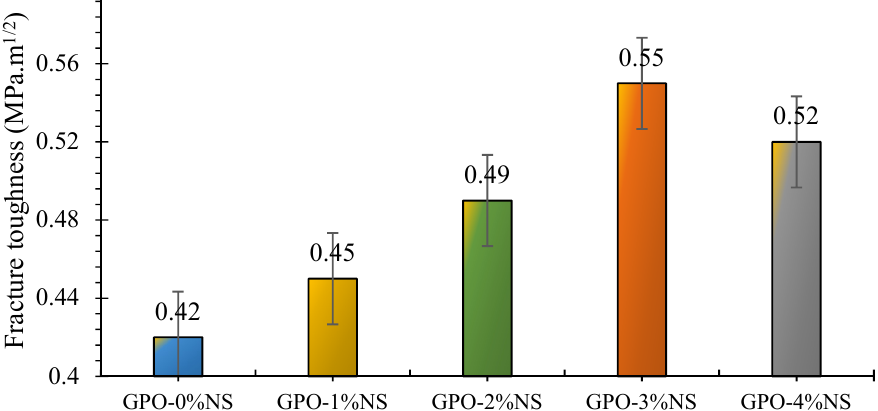
Figure 15. FRT of carbon-fiber-reinforced GPO composite pastes with various contents of NS. With the increase in NS content from 1% to 3%, the FRT of pastes increased, reaching 0.55 MPa · m 1/2 at 3% NS. Regardless, the FRT of the GPO composites containing NS was